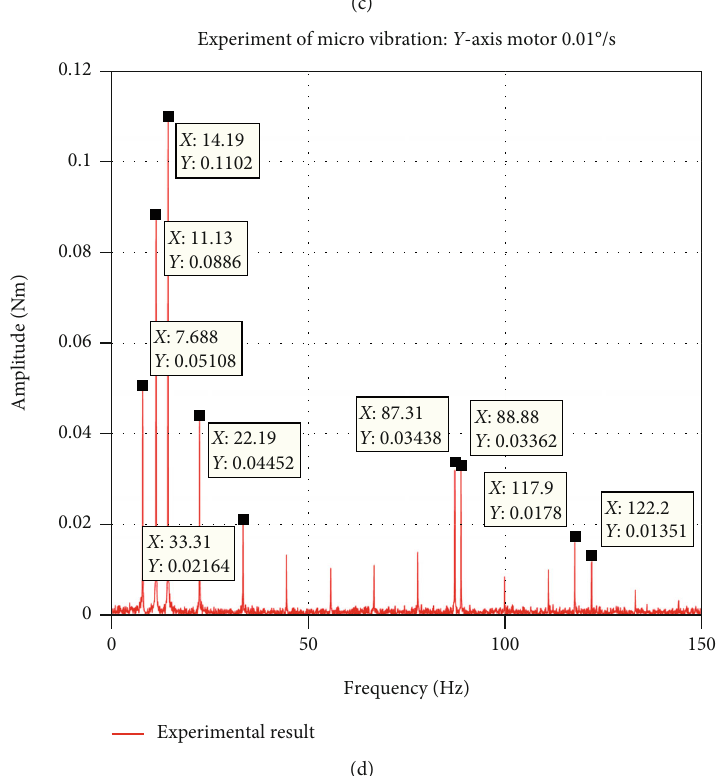
Figure 7: Simulation results of microvibration frequency domain curve: (a) x -axis motor, (b) y -axis motor and experimental results of microvibration frequency domain curve: (c) x -axis motor, (d) y -axis